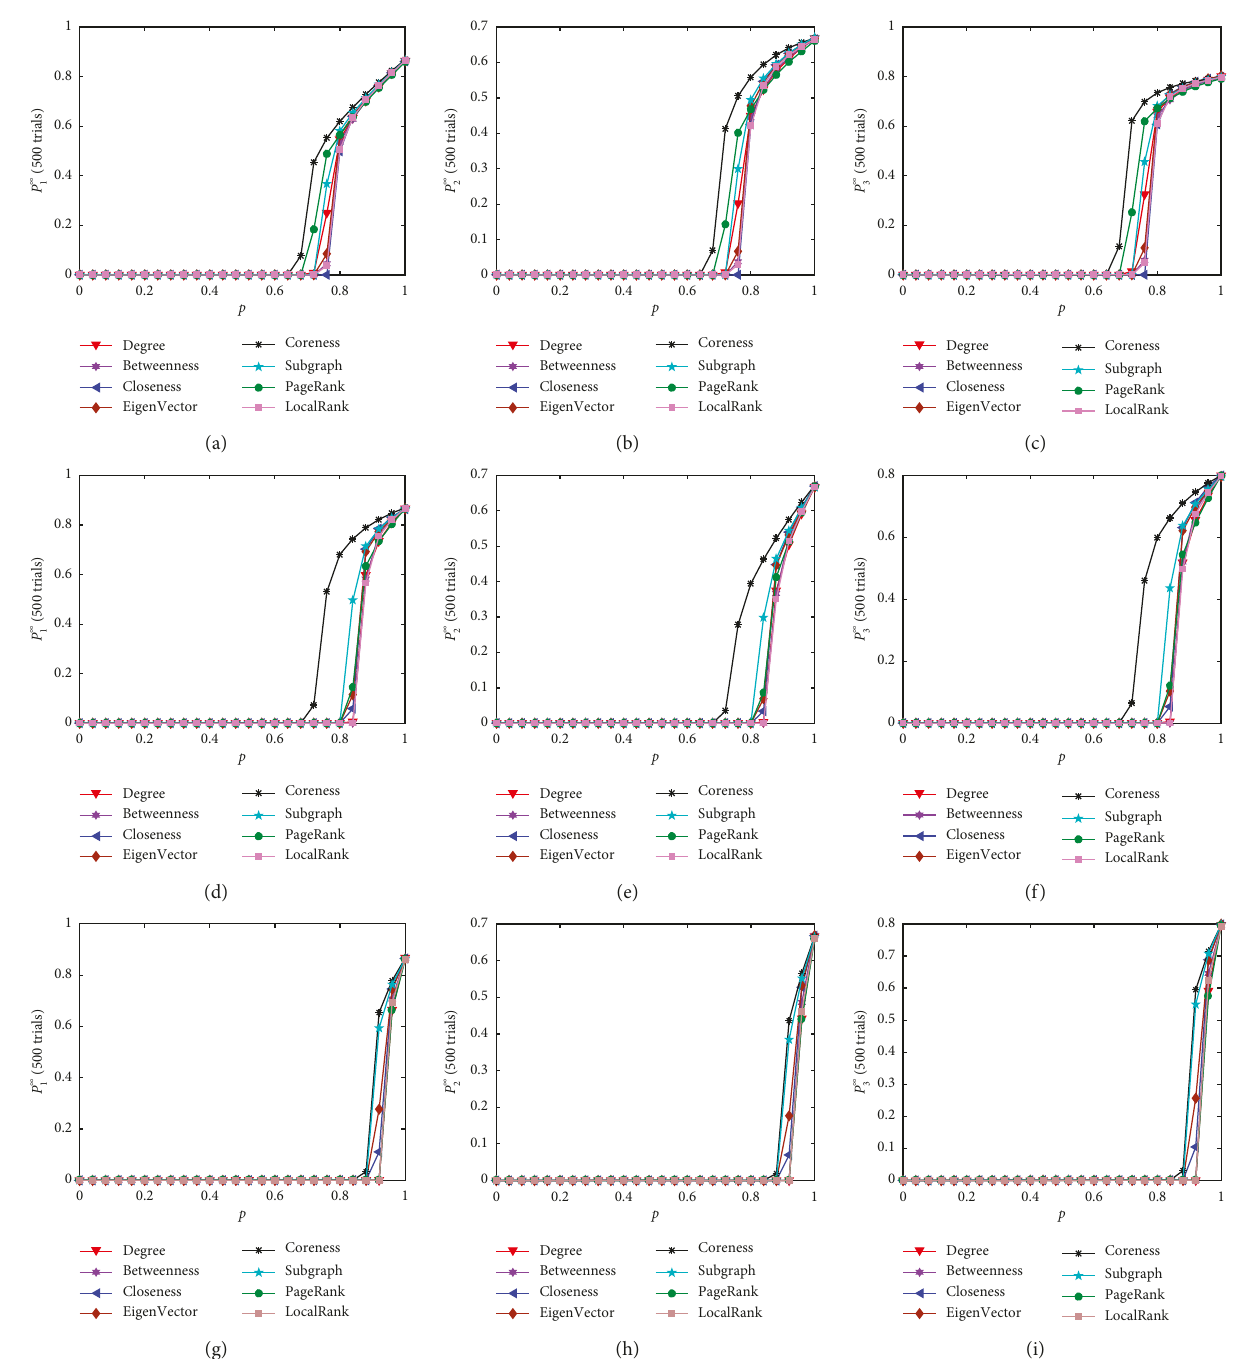
Figure 8: Model M2-based robustness of tripartite network G G V that also belong to the LCC, are drawn with respect to different values of p. (a–c) the case where the node attacks occur to V i ⊂ 1 the case where the node attacks occur to V